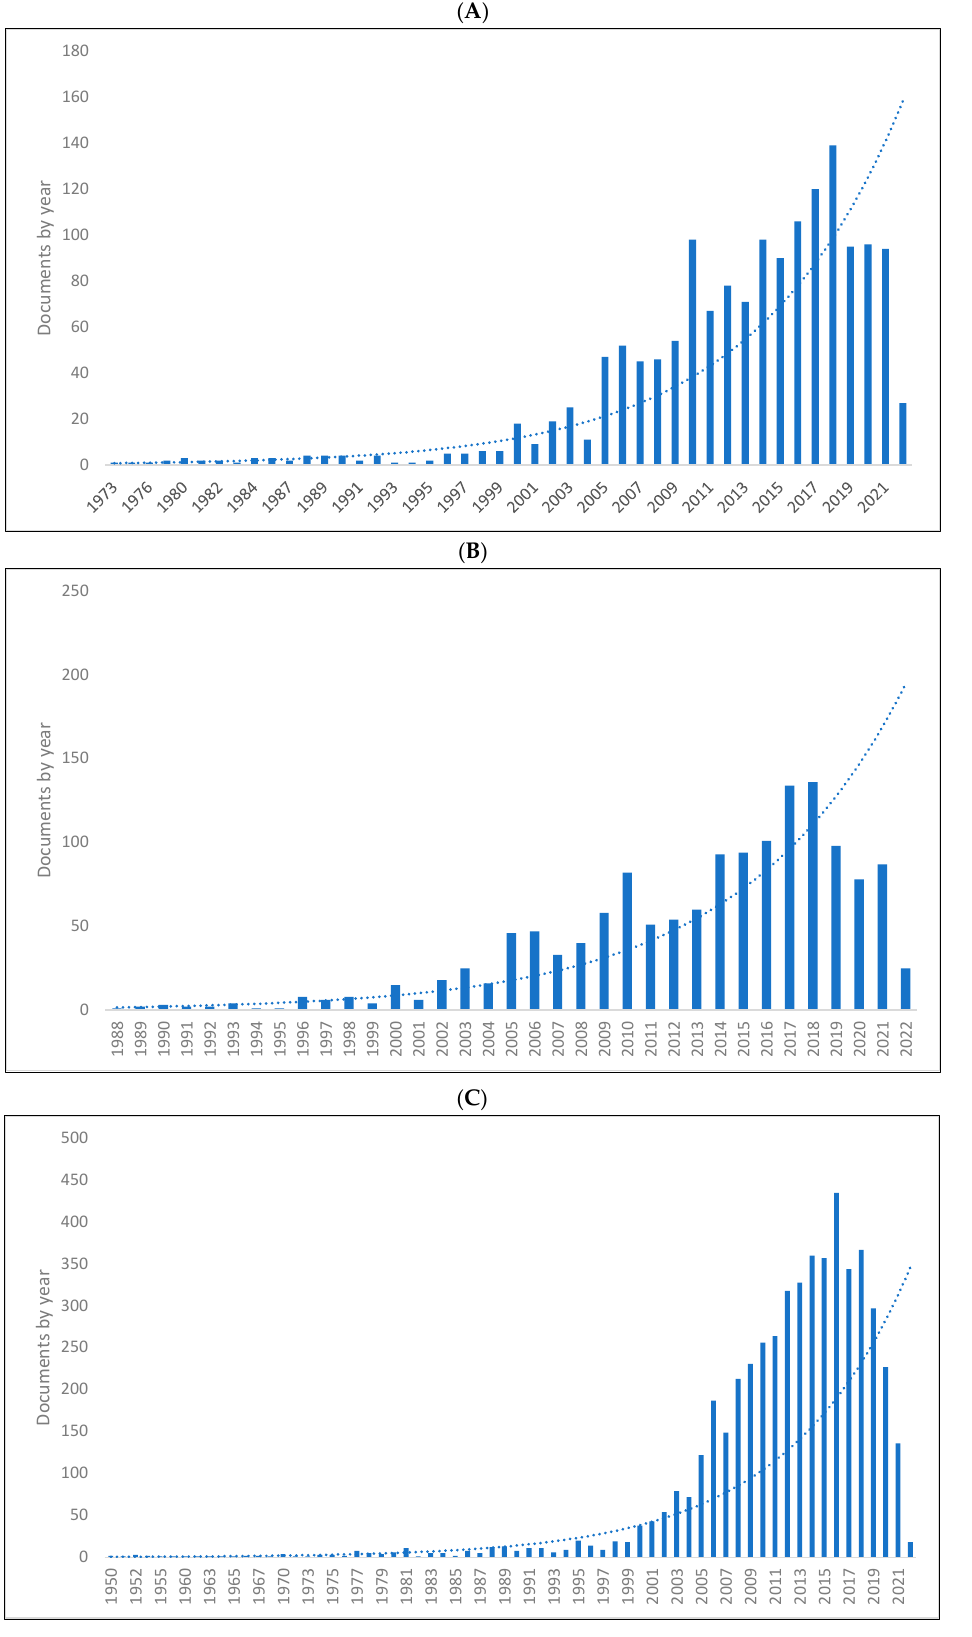
Figure 1. Knowledge production size in biolinguistics by year. ( A ) (Scopus), ( B ) (WOS), ( C ) (Lens).